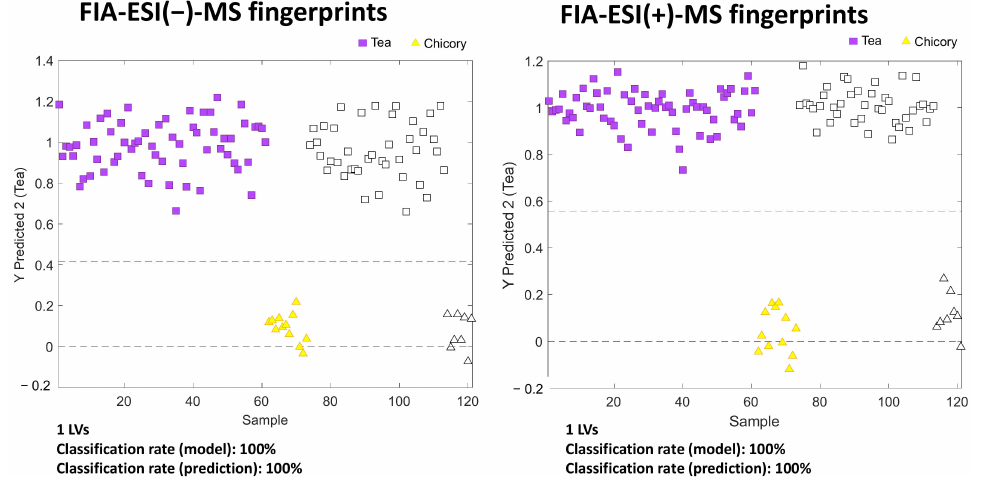
Figure 4. Validation of the paired PLS-DA models of all tea product varieties versus chicory when using FIA-MS fingerprints from negative- and positive-ionization modes as the sample chemical descriptors. Red line means the separation threshold between classes. Filled and empty symbols correspond to the calibration and validation sets,